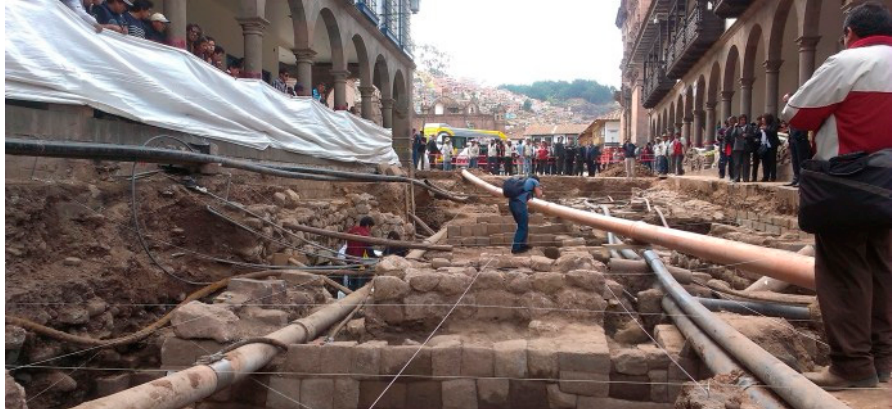
Figure 1. Archaeological find in Calle Mantas, one of the entrance ways to Plaza de Armas (courtesy of ANDINA/Percy Hurtado Santillán).